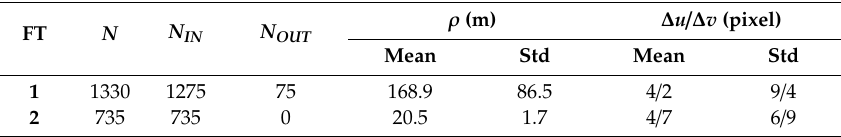
Table 2. Statistics of the FTs for database